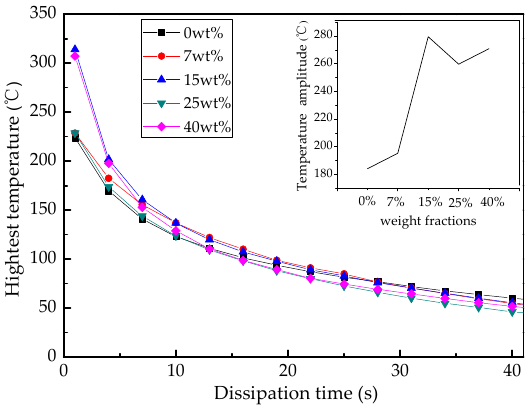
Figure 12. The highest temperature distribution on the surface of the front side samples recorded 40 s after breakdown.